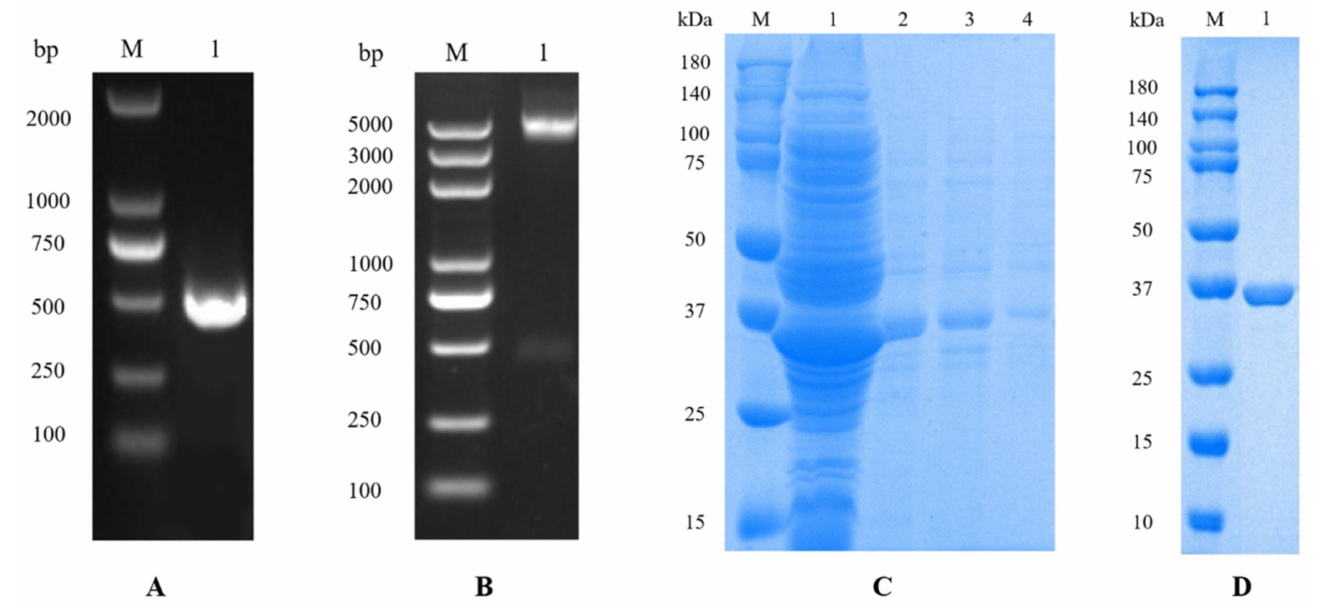
Figure 1. Gene cloning, expression, and protein purification of SsTCTP. ( A ): PCR amplification of the SsTCTP gene (M: gene marker DL2000; 1: PCR product); ( B ): identification of recombinant pET-32 α -SsTCTP using double digestion (M: gene marker DL5000; 1: recombinant plasmid digested by BamHI and Hind Ш ); ( C ): solubility analysis of rSsTCTP (M: protein marker; 1: supernatant; 2: 2 M urea dissolved; 3: 4 M urea dissolved; 4: 8 M urea dissolved); ( D ): purification of rSsTCTP (M: protein marker; 1: purification of rSsTCTP). SsTCTP, Sarcoptes scabiei translationally controlled tumor